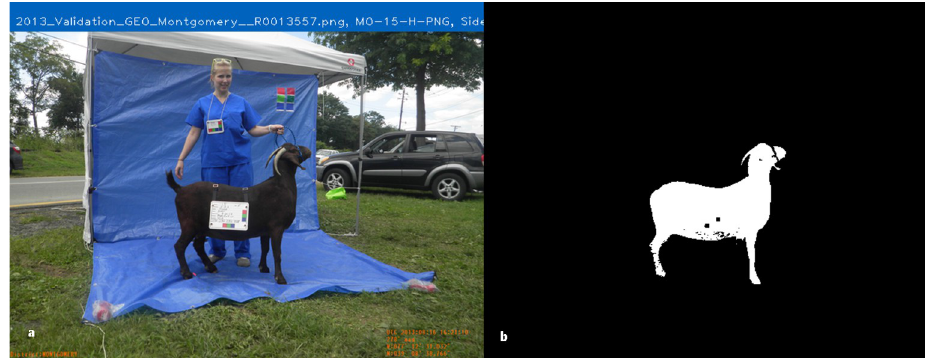
Fig 1. Image Matting, a) original image, b) alpha matte or mask